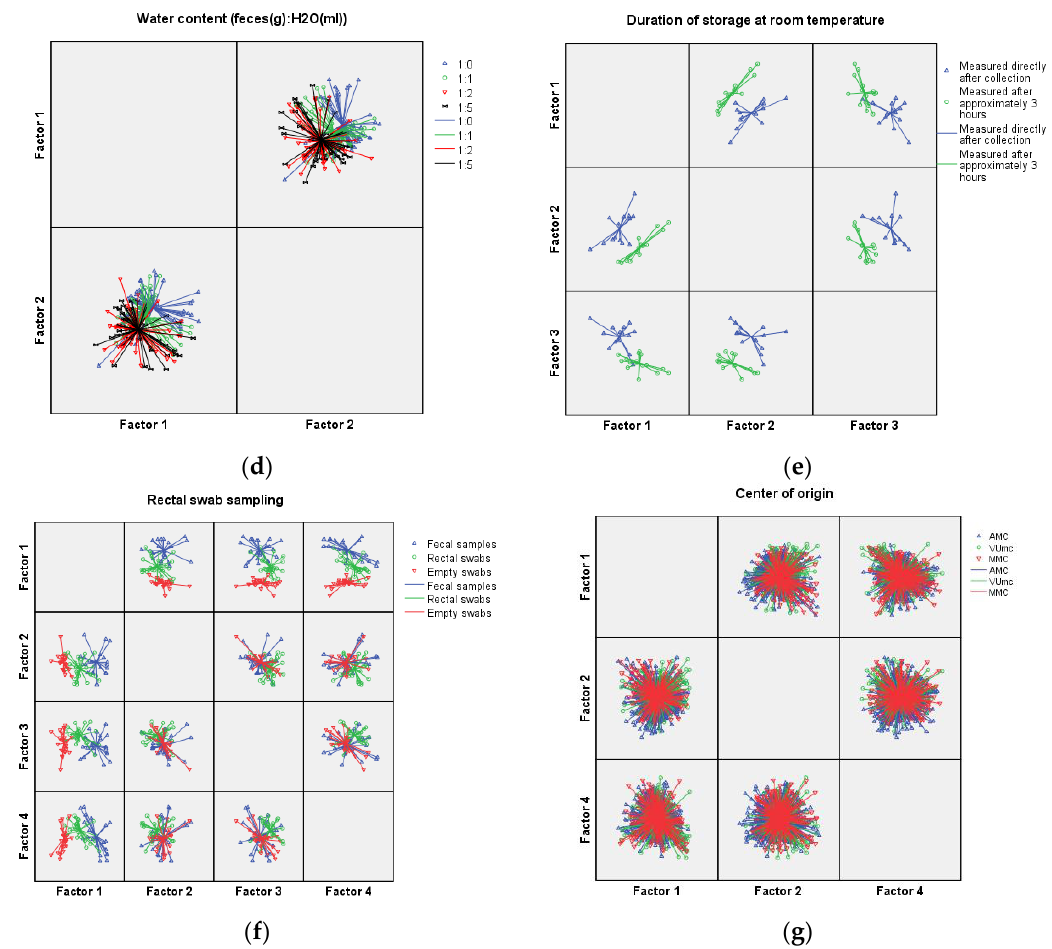
Figure 1. ( a – g ) Scatterplot for the discrimination by electronic nose based on difference in several variables, including: ( a ) sample mass; ( b ) number of freeze–thaw cycles; ( c ) sample temperature; ( d ) water content; ( e ) duration of storage at room temperature; ( f ) rectal swabbing; and ( g ) center of origin. Axes depicted are orthogonal linear recombinations of the raw sensor data by means of principle component analysis. Illustrated axes solely comprise principle components demonstrated to be statistically significant different for the variable concerned. Individual VOC profiles are illustrated as marked points. The intersection of the lines deriving from the individual profiles demonstrates the mean VOC profile of this specific variable. All evaluated sampling conditions have a significant influence on detected fecal VOC profile, only dilution from 1:2 to 1:5 did not affect outcome.